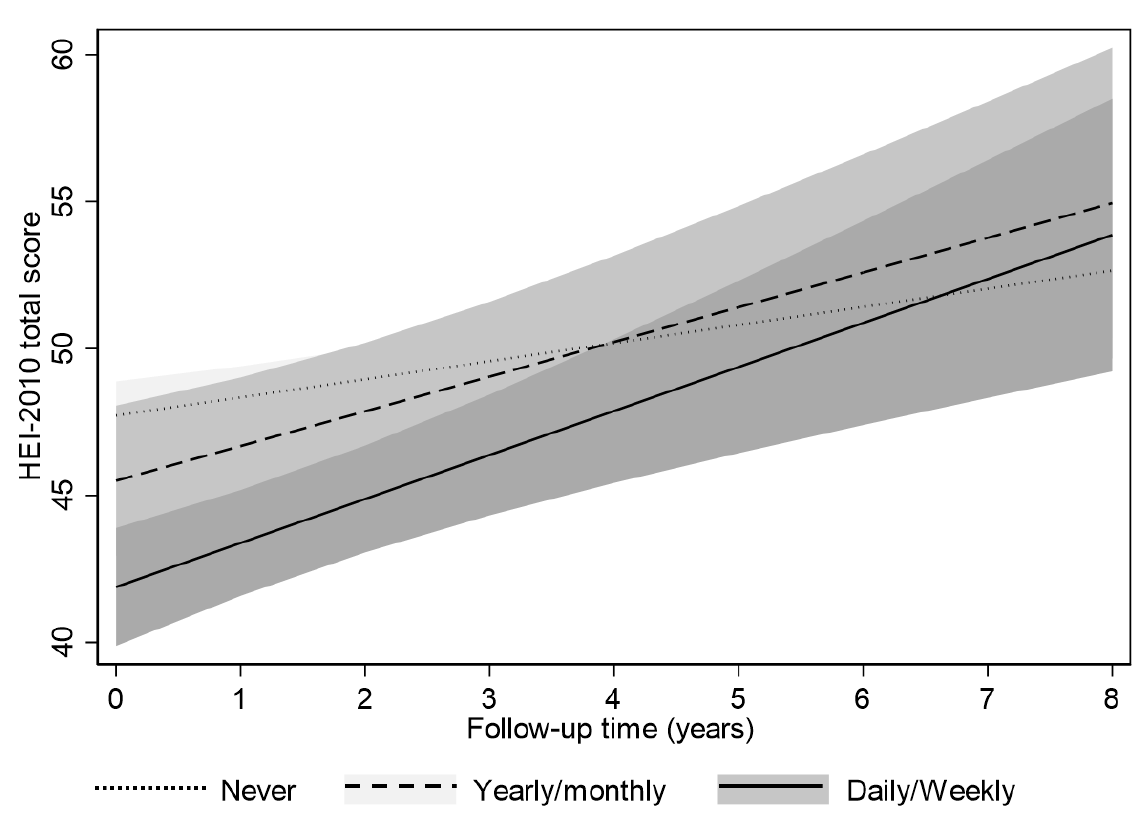
Figure 1. Predictive margins with 95% confidence intervals (CI) of HEI-2010 total score over time, across frequency of caregiving for grandchildren (question 3) among Whites. Note: predictive margins were created with 95%CI using fixed portion of the mixed effects regression model, adjusting for age, sex and poverty status, Model 2 ( Table 4 ). Table 4. Longitudinal Associations of caregiving exposures (X = recoded questions 3 and 6) with diet quality (Y = HEI- 2010 total score) over time, stratified by race, for HANDLS participants (N = 1674) [γ ± SE, p -value]: Mixed-effects linear regression models 1 .